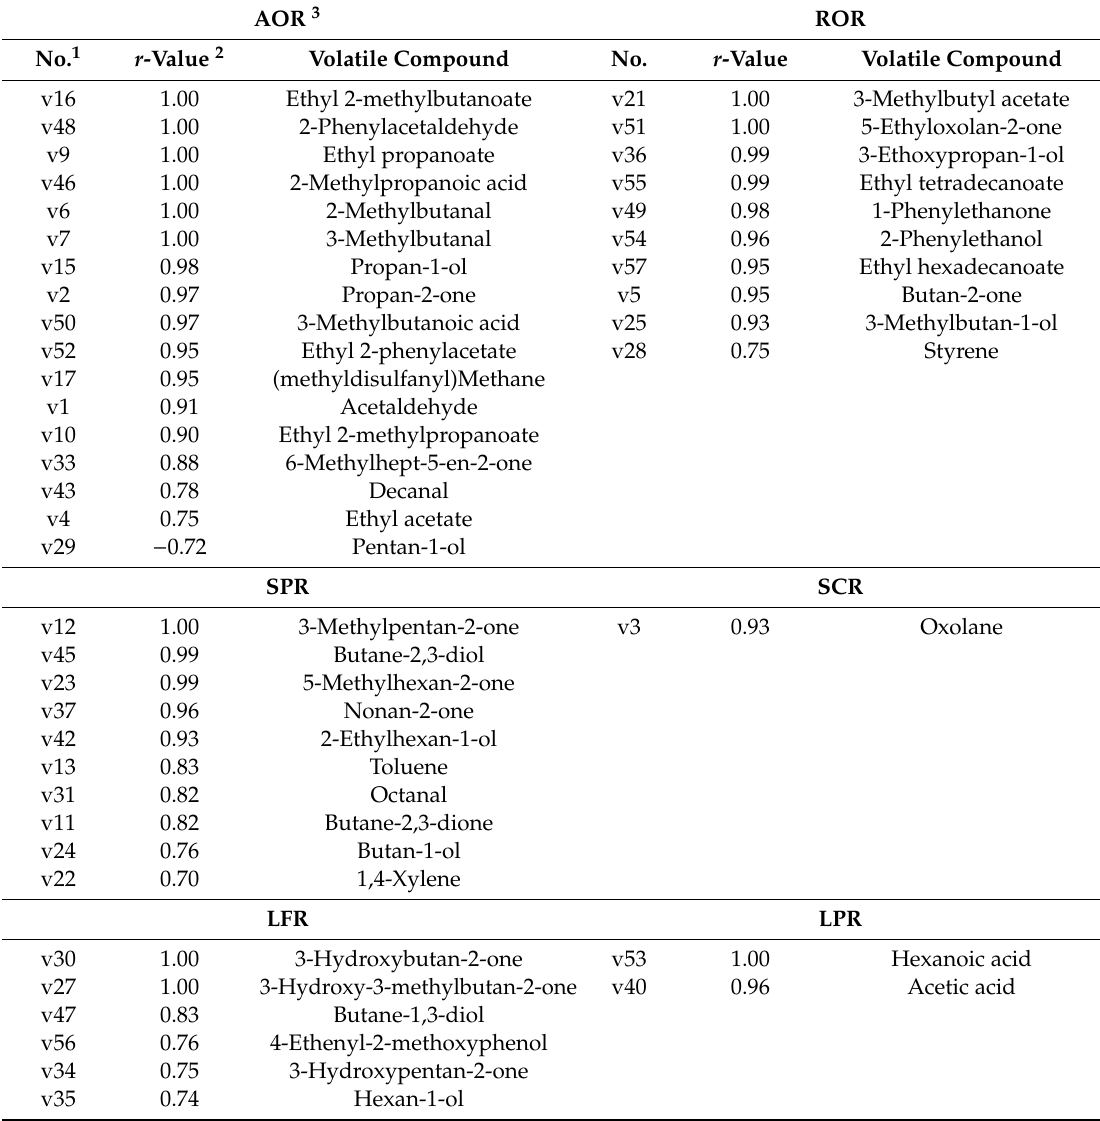
Table 3. Distinctive volatile compounds of fermented rice